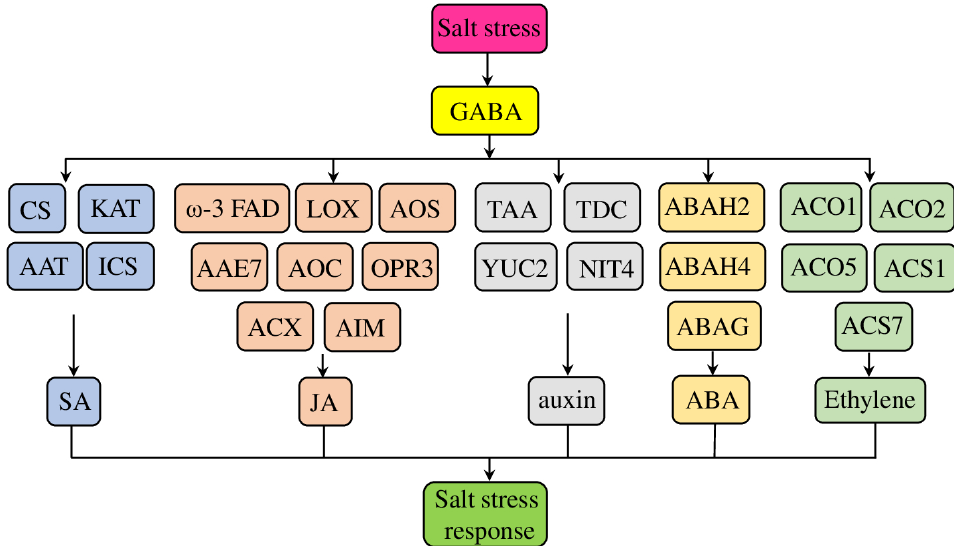
Figure 5. Proposed model of the cross-talk between salt stress, GABA, selected phytohormones